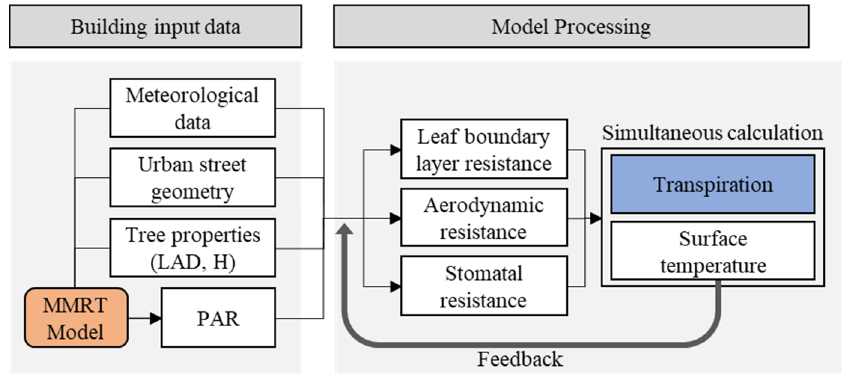
Figure 1. Model flow for calculating the transpiration.